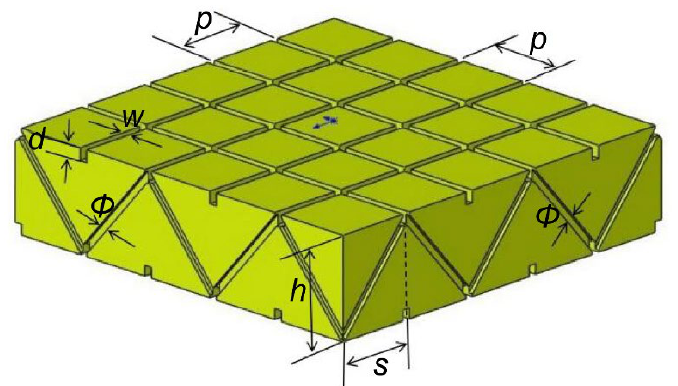
Figure 6. Warren truss slot structure with double-sided square shallow grooves and symmetrical inclined holes. p is the groove spacing, w is the shallow groove width, d is the groove depth, Φ is the symmetrically inclined hole diameter, s is the inclined span of the hole, and h is the inclined hole